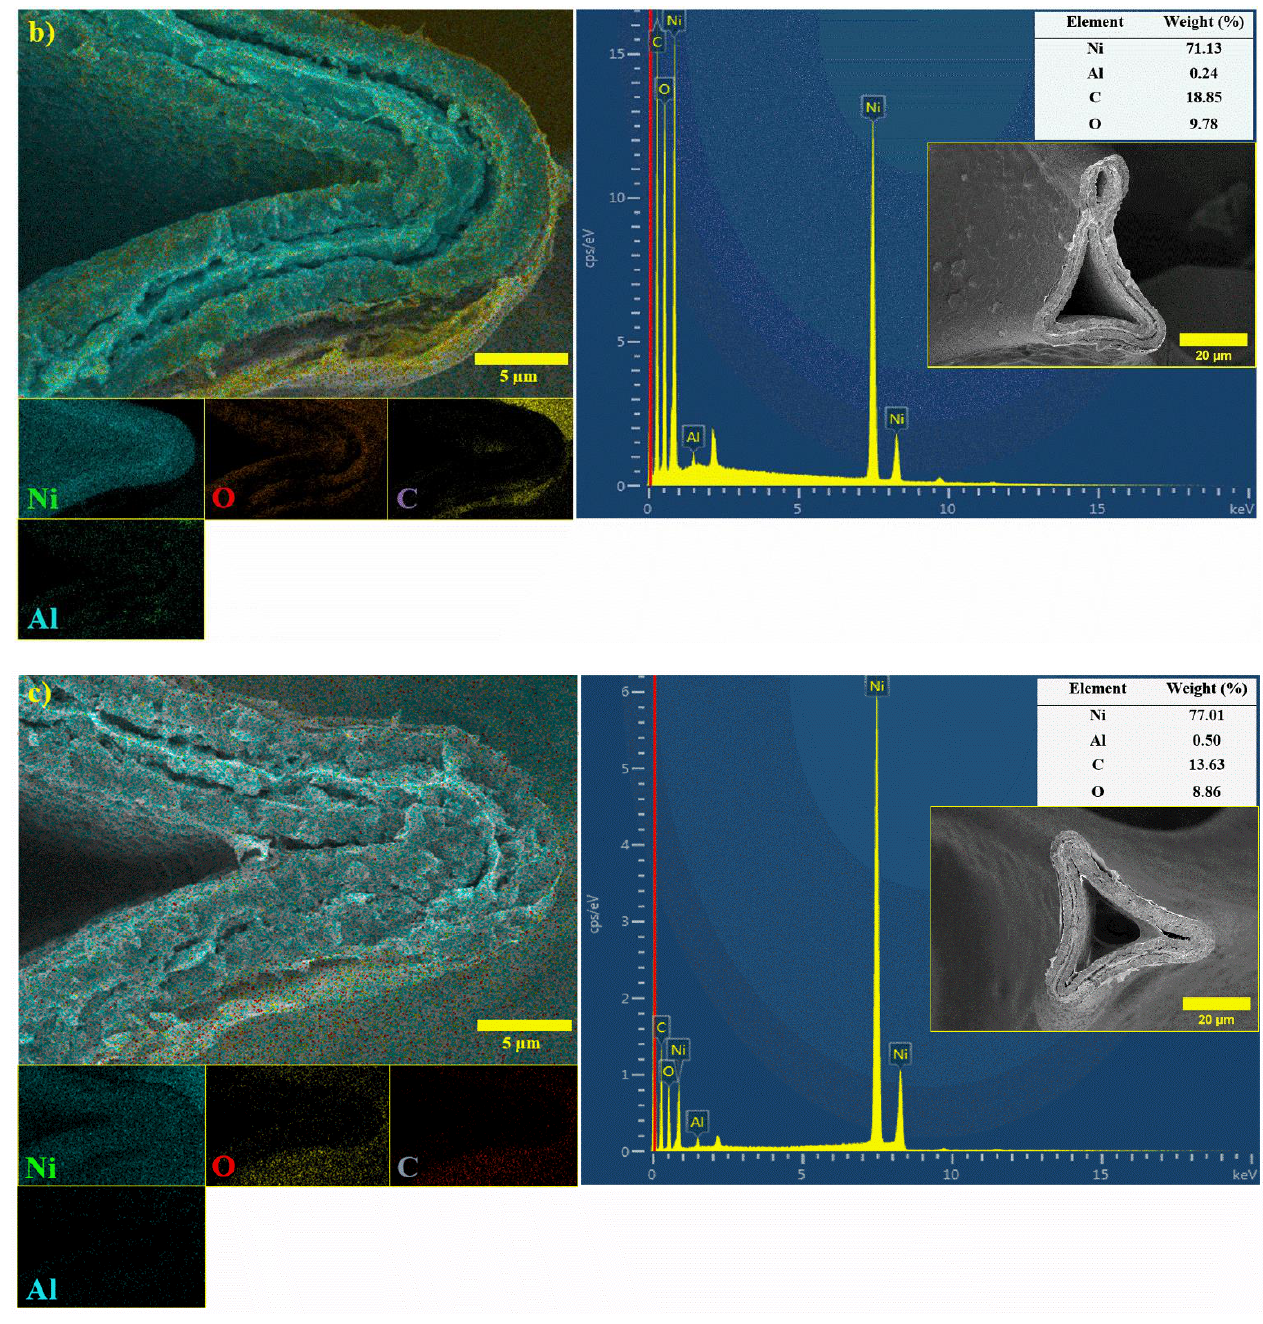
Figure 4. Cross-sectional SEM images and EDS analysis for ( a ) NiO/Ni@PAN-(PAN-PVA)-PVA, ( b ) NiO/Ni@PAN-(PAN-PVA)-PVA with the addition of 0.25 wt% Al 2 O 3 , and ( c ) NiO/Ni@PAN-(PAN-PVA)-PVA with the addition of 0.5 wt% Al 2 O 3 . FTIR results confirm the presence of polymers PAN and PVA layers after